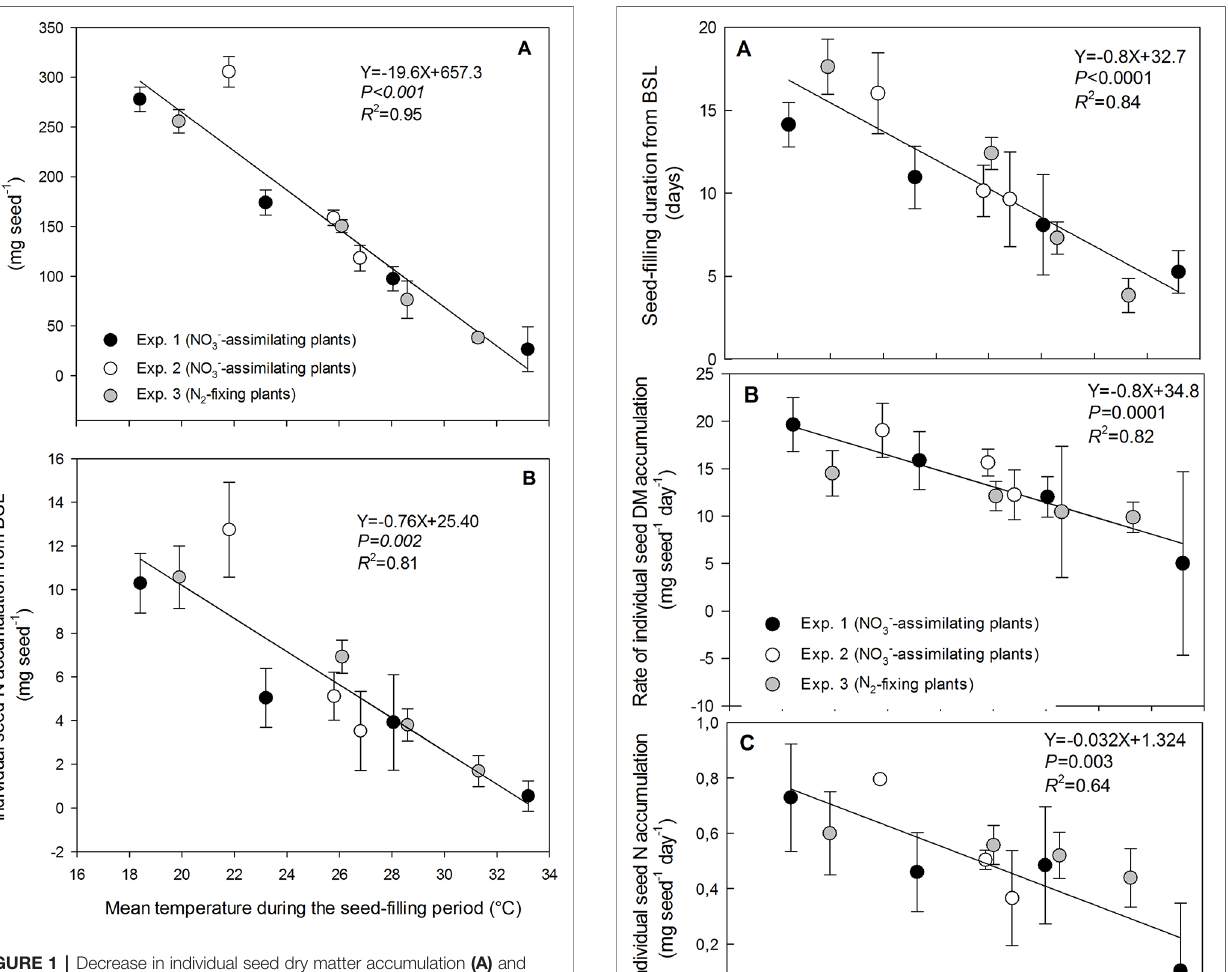
FIGURE 1 | Decrease in individual seed dry matter accumulation (A) and individual seed nitrogen accumulation (B) with increasing temperature of the treatments during the seed- fi lling period. Pea plants were exposed to temperature treatments from the beginning of seed fi lling of the last reproductive node (BSL) to plant maturity. The vertical bars represent SE (when larger than symbol). The data were fi tted with a linear regression.